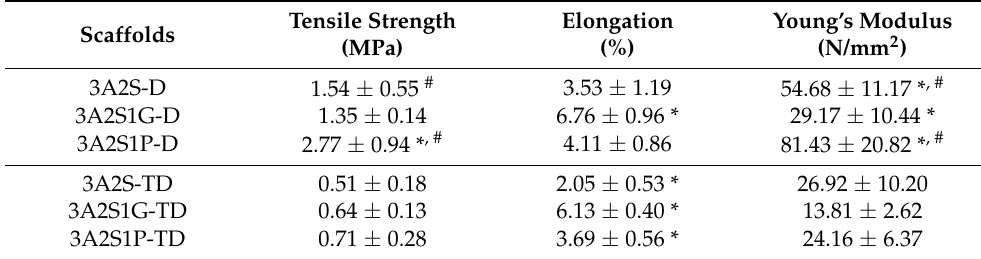
Table 1. Mechanical properties of all scaffolds. Tensile Strength Scaffolds (MPa)